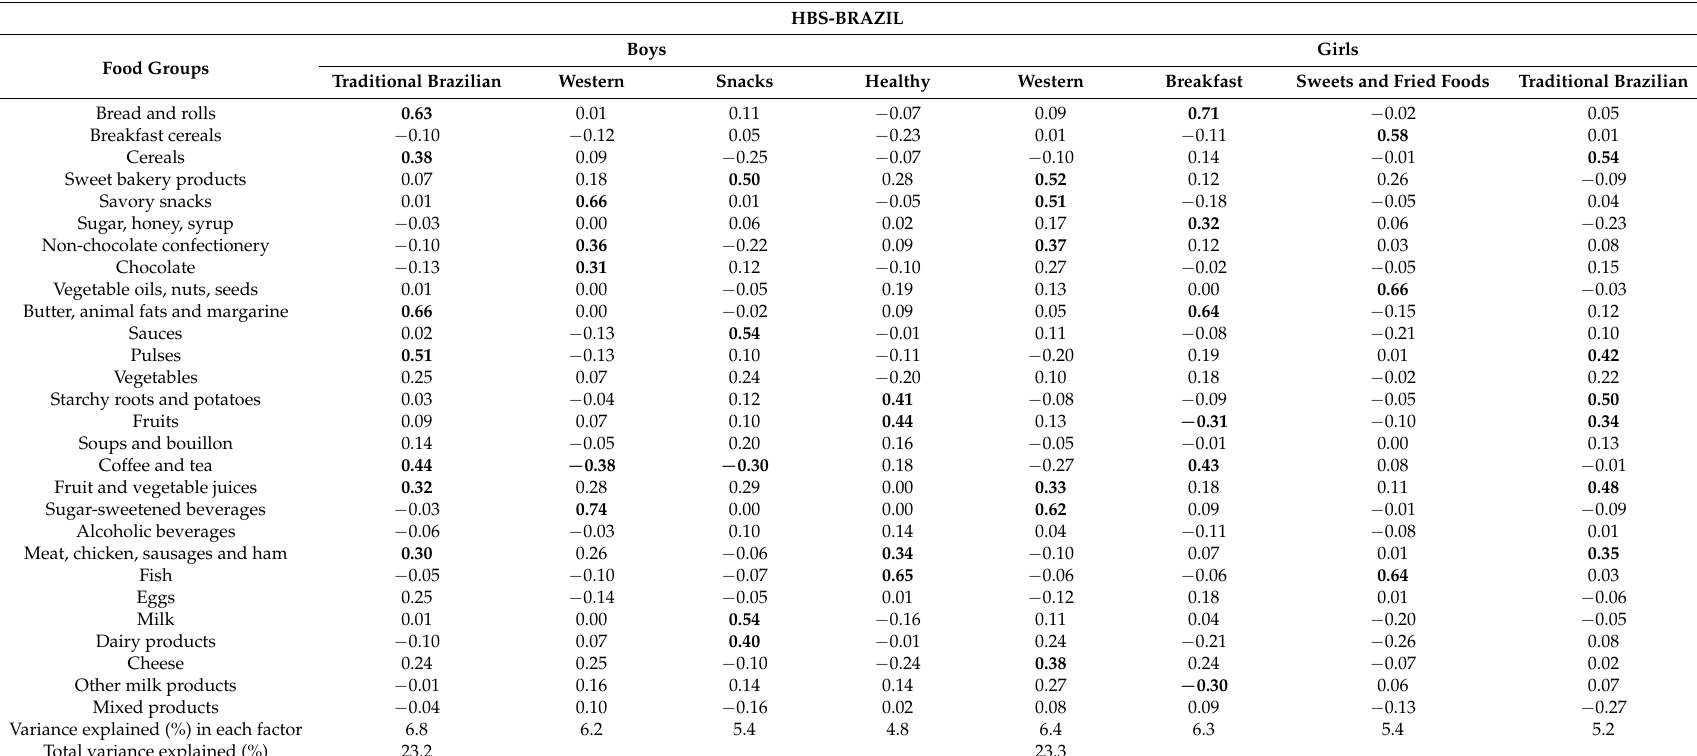
Table 3. Factor loadings of food groups present in the dietary patterns identified among adolescents from HBS-Brazil 2008/2009